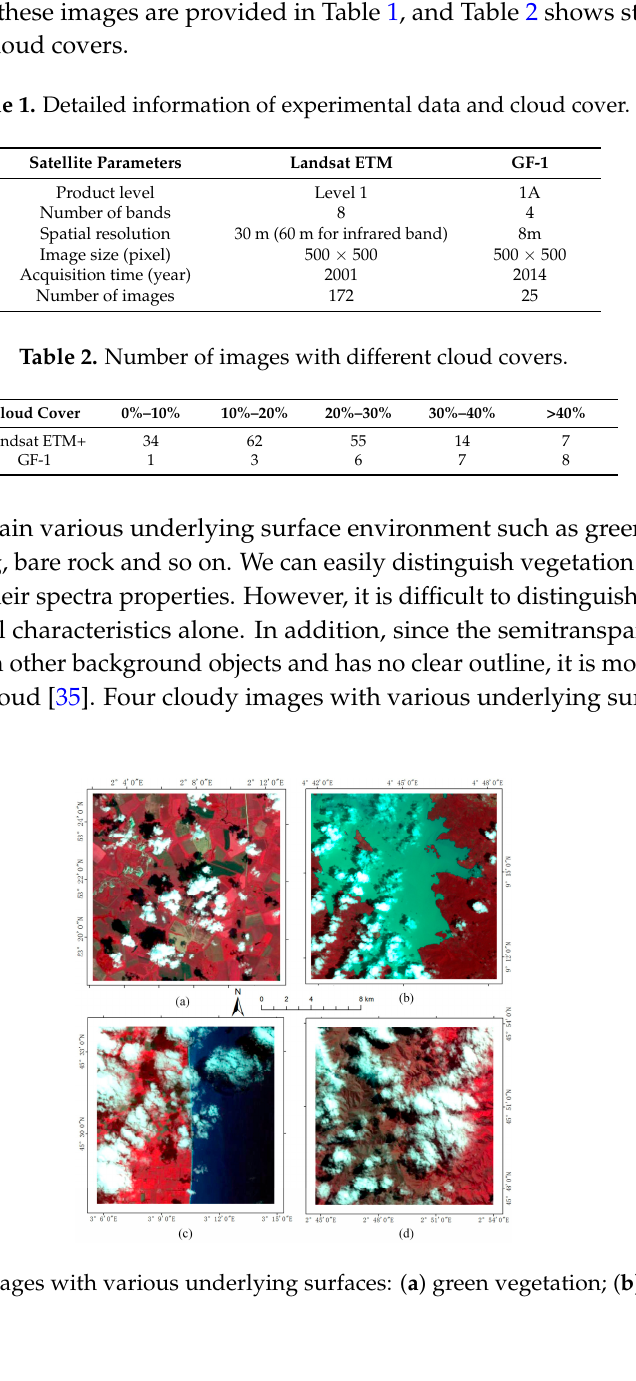
Table 1. Detailed information of experimental data and cloud cover.